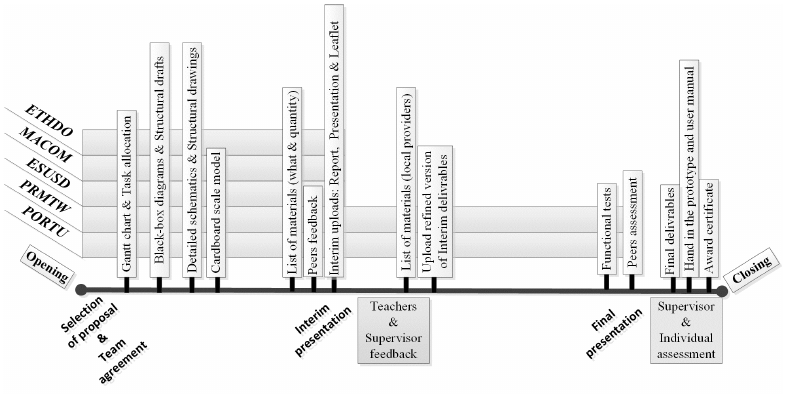
Fig. 1. Main activities and milestones of